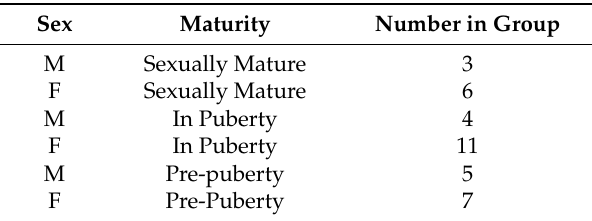
Table 2. Orcas with no reported incidents.